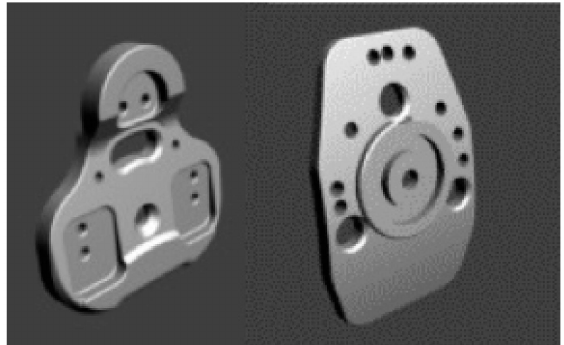
Figure 1. Cleat system nº ES